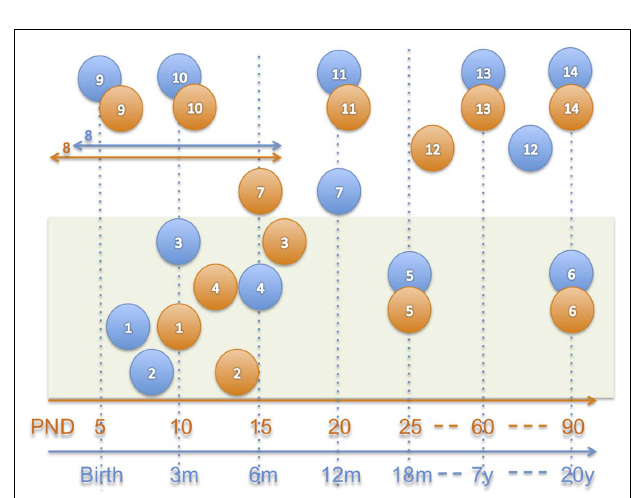
animal scanner (9.4 T Bruker). With primary interest in anatom-